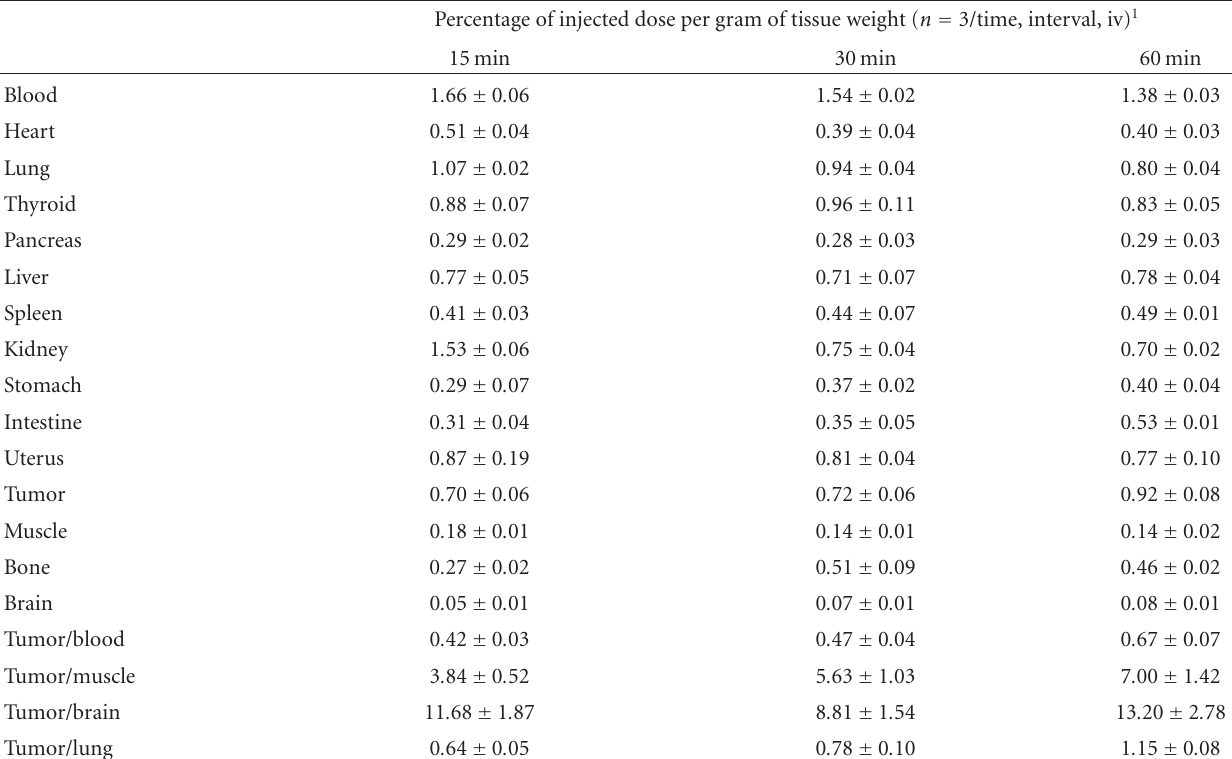
1 Values represent the mean ± standard deviation of data from 3